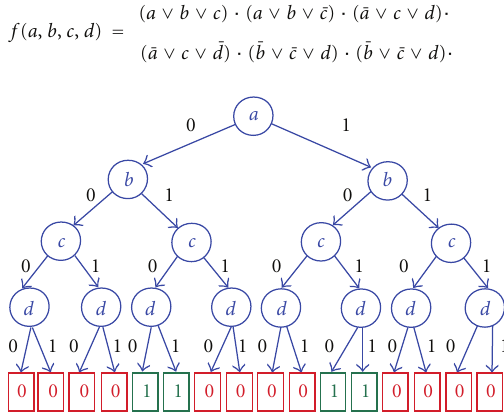
Figure 1: An example of a satisfiable SAT instance showing its corresponding decision